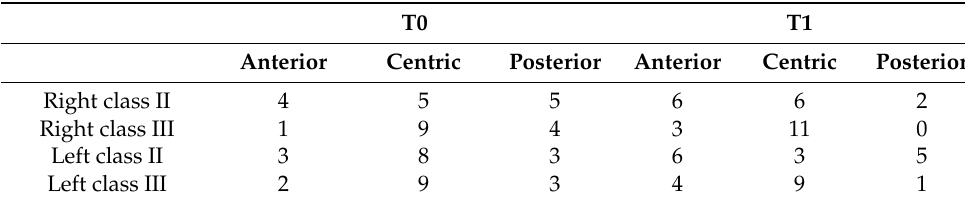
Table 5. The condylar position pre- and post-surgery according to Pullinger et al.’s formula [26,27] ( n =